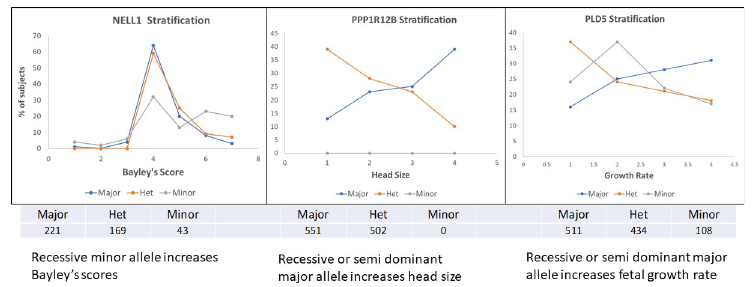
Fig 8. The distributions of phenotypes by genotype for three of the pairwise genetic variant effects. The numbers of subjects with each genotype are shown under each panel. a . NELL1 shows a distribution that suggests a strong dominance of the major allele for the Bayley scale score distribution. b . PPP1R12B shows a diametrically opposite distribution between the homozygote and heterozygote. c . PLD5 shows the same as in b) but with a distinct homozygous minor